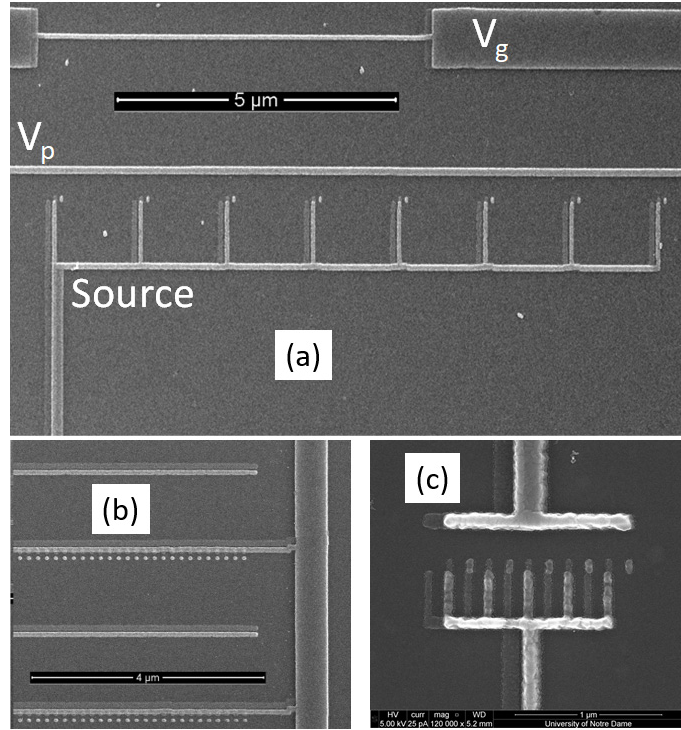
Figure 9. ( a ) High resolution SEM image of an array composed of 8 SEBs. Probing gate is located in close proximity to the array and has nominally equal coupling to each SEB. Tuning gate is located farther away and is unequally coupled to each SEB element. ( b ) example of an array composed of a large number of SEBs (> 1000). Small dots below the lines are secondary islands resulting from the Dolan bridge process, and the two horizontal lines leading to the left are the gate. ( c ) An example of a self-aligned 9 SEB array with a footprint less than 1 × 1 µm 2 .